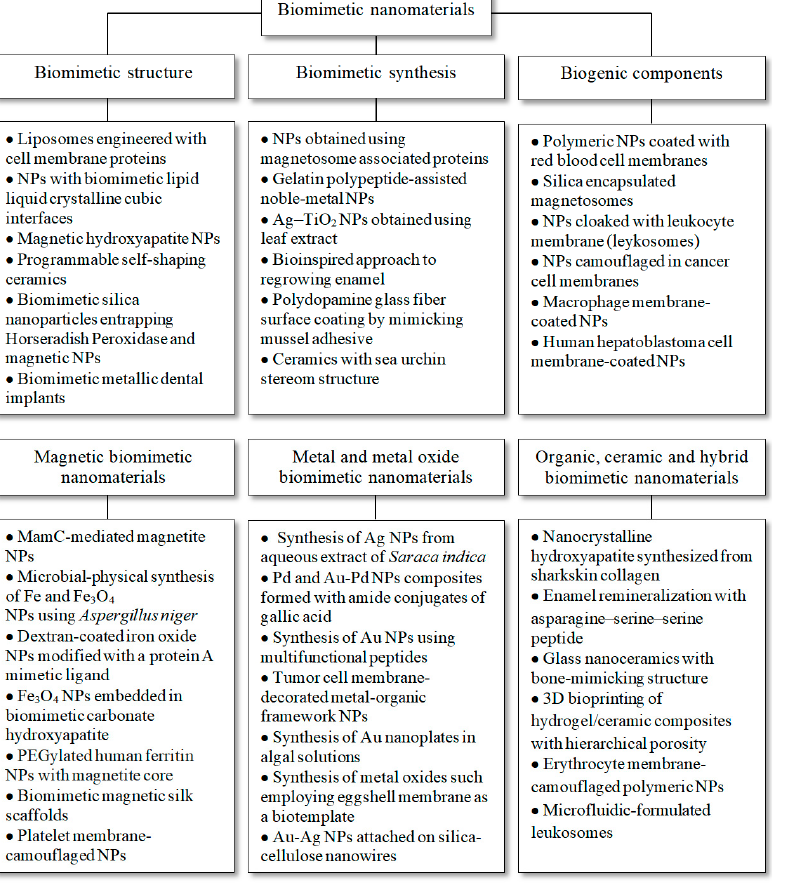
Figure 2. Classification of biomimetic nanomaterials (BNMs) based on the literature data, includ ‐ ing information on biomimetic structure [16,34–38], biomimetic synthesis [32,39–43], biogenic components [31,33,44–47], magnetic BNMs [48–54], metal and metal oxide BNMs [55–61], organic, ceramic and hybrid BNMs